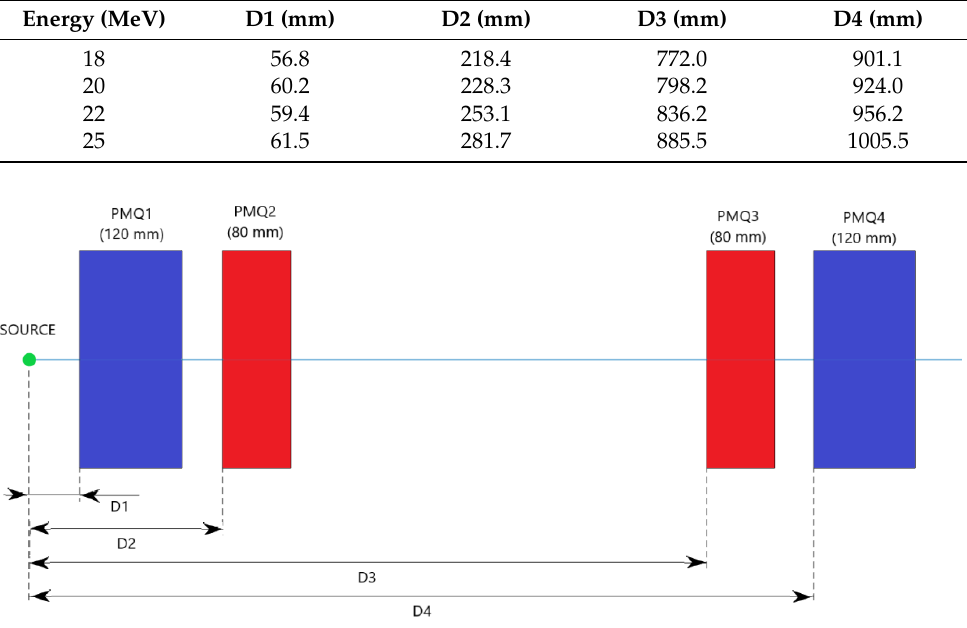
Figure 2. Layout of the collection and focusing section configuration. Values of the initial relative positions of the quadrupoles (D1, D2, D3, and D4) per each energy configuration are given in Table 2.